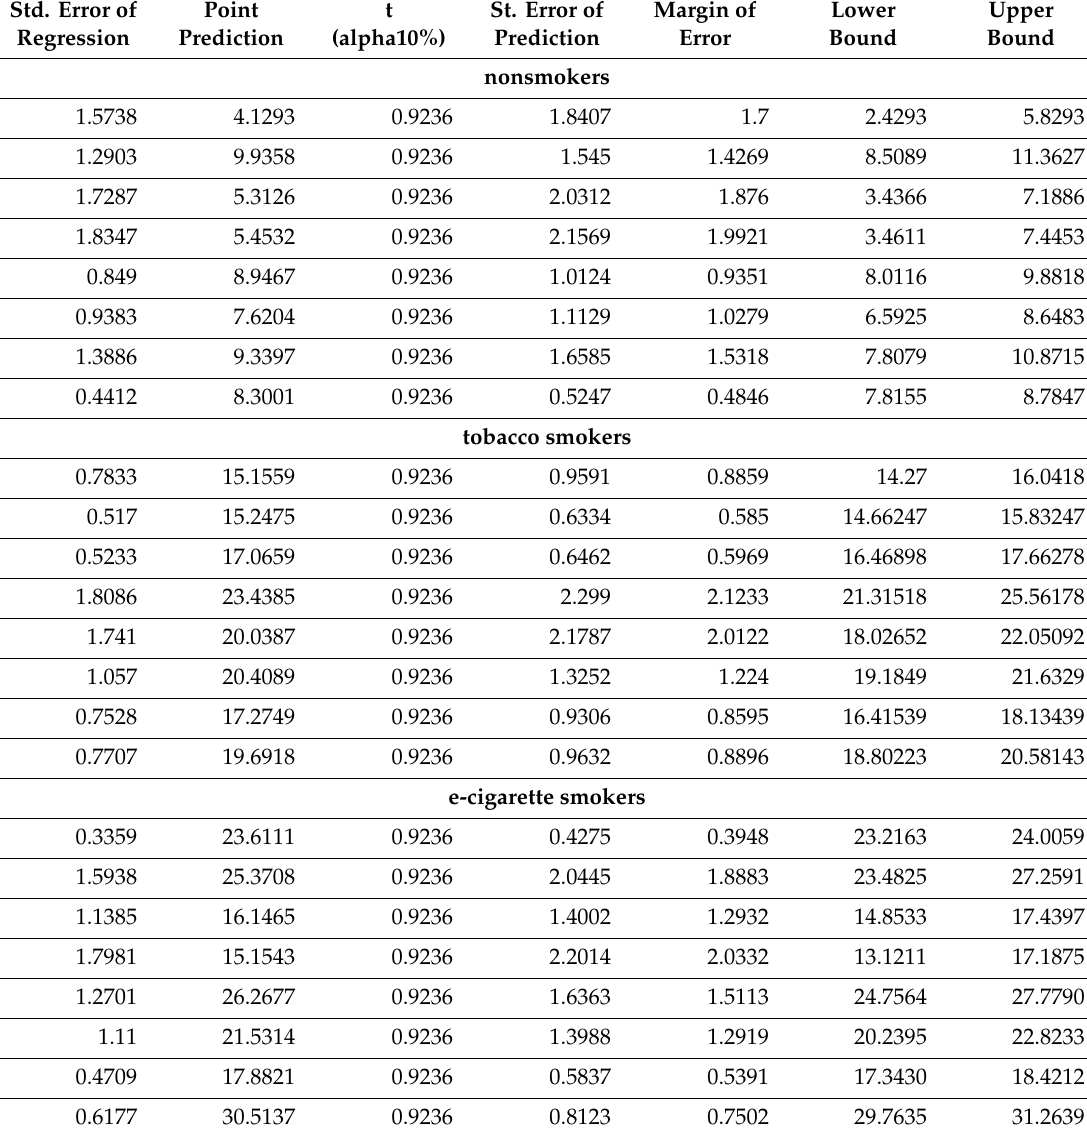
Table 4. A point prediction and prediction interval for the thiocyanate concentration in saliva samples and given Y (0) value in a simple regression.